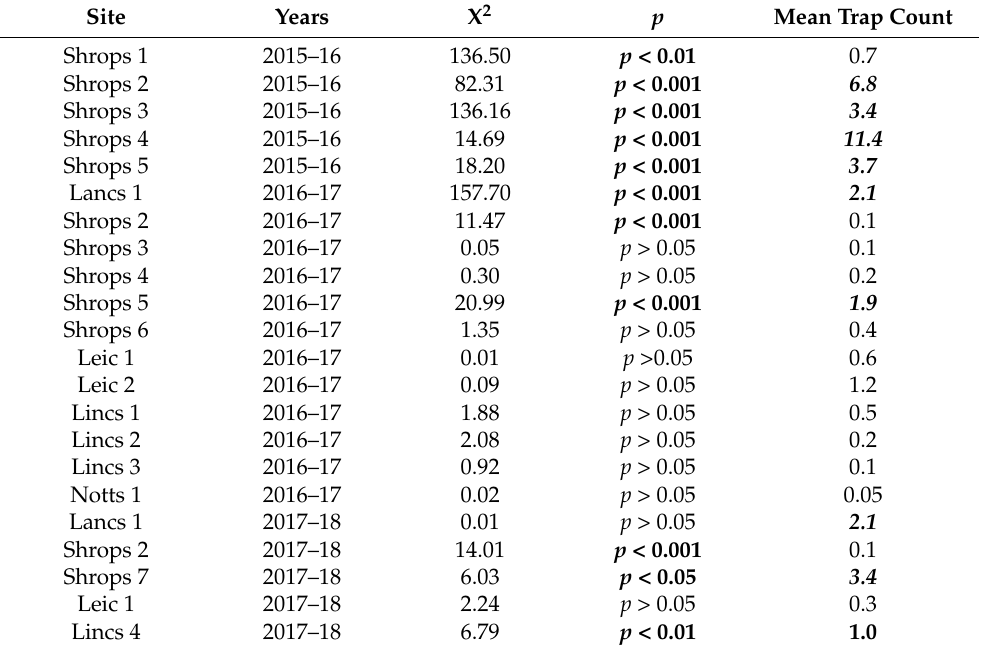
Table 4. Spatial clustering of slug activity identified by catches of surface refuge traps arranged in a 10 × 10 grid of refuge traps, set within a rectangular 1ha plot in each field, and mean number of slugs caught, in 22 field sites from three growing seasons. The effect of trap location within the grid on slug numbers was investigated using a Poisson GLM mixed effects model, with main effects extracted using the Anova function in R (X 2 ; p ). Consistent differences between the catches of individual traps (indicating potential spatial clustering of slug activity) are highlighted in bold, and mean trap catches exceeding an arbitrary “low population size” of 1.5 per trap in